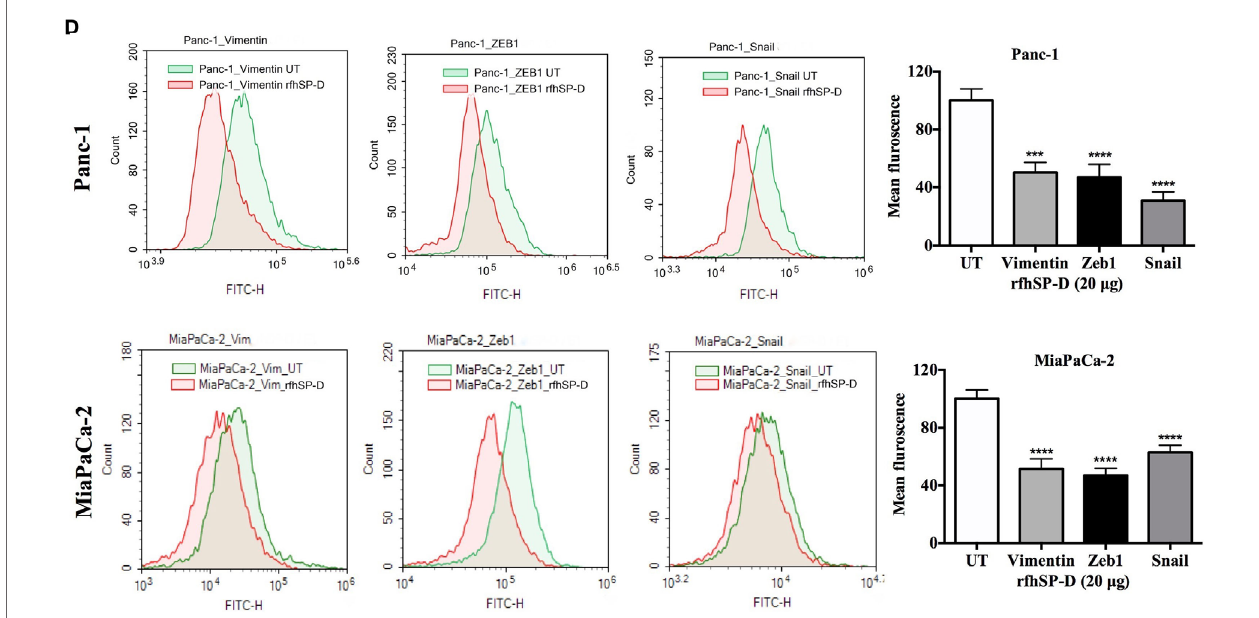
FigUre 6 | Recombinant fragment of human SP-D (rfhSP-D) downregulates the expression of epithelial-to-mesenchymal transition (EMT) markers (Vimentin, Snail, and Zeb1). (a) All cell lines were incubated with and without rfhSP-D (20 µg/ml) for various time points and total RNA was extracted to synthesize cDNA. Each qPCR reaction was carried out in triplicates and human 18S RNA, an endogenous control, was used to normalize the gene expressions. The cycle threshold mean was used to calculate the relative expression to compare treated and untreated. EMT inducers, Vimentin, Snail, and Zeb1, were significantly downregulated across all cell lines. Significant values were considered based on * p < 0.05, ** p < 0.01, *** p < 0.001, and **** p < 0.0001 between treated and untreated samples. (b) Vimentin intracellular staining for all cell lines using 0.5 × 10 5 cells incubated with and without rfhSP-D (20 µg/ml) for 24 h followed by probing with rabbit anti-human Vimentin antibody (1:500) and then with Alexa Fluor 488 conjugated with FITC (1:500) and Hoechst (1:10,000) for immunofluorescence analysis showed bright green fluorescence in the cytoplasm of the untreated cells as compared to very weak staining in the rfhSP-D-treated cells. (c) Zeb1 intracellular staining for all cell lines using 0.5 × 10 5 cells incubated with and without rfhSP-D (20 µg/ml) for 24 h followed by probing with rabbit anti-human Zeb1 antibody (1:500) and then with Alexa Fluor 488 (1:500) and Hoechst (1:10,000) for immunofluorescence analysis showed bright green fluorescence in the cytoplasm of the untreated cells of all cell lines as compared to minor staining in the treated cells of Panc-1 and MiaPaCa-2. (D) The quantitative analysis of the mean fluorescence of Vimentin, Zeb1, and Snail of Panc-1 and MiaPaCa-2 cell lines showed a significant reduction in the rfhSP-D-treated cells as compared to untreated counterparts. Significant values were considered based on **** p < 0.0001 between treated and untreated